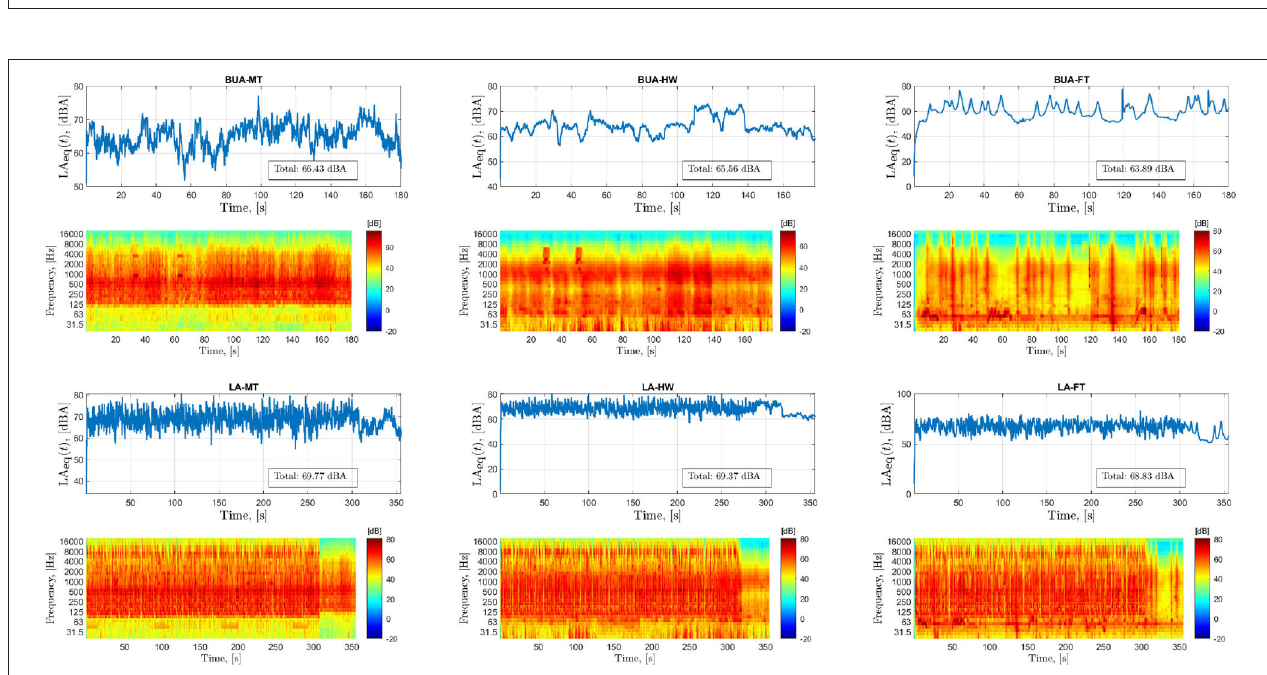
FIGURE 2 | Acoustic characteristics of stimuli presented in different listening conditions. Each panel corresponds to one of the sound fragments presented during the conditions labeled at the top of each panel. The line plots show the sound level fluctuation with time (A-weighted, equivalent continuous sound level in decibels, LAeq). The averaged LAeqs over the whole duration of the fragment have been annotated in the line plots. The heatmaps show the standard spectrogram of the sound fragments (with time resolution of 0.01 s and one-third octave frequency bands). LA, lecture attended; BUA, background unattended tasks; MT, multi-talker; HW, highway; FT, fluctuating traffic background